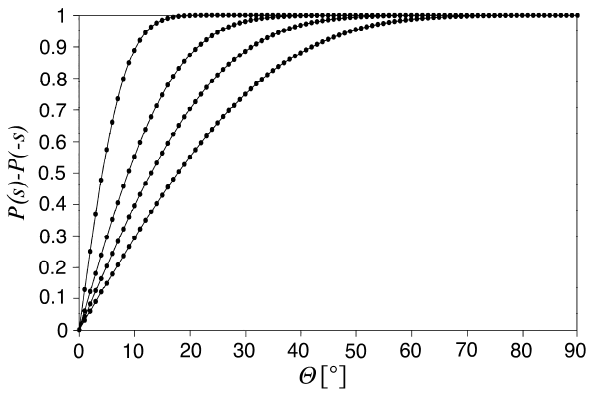
Fig. 3. The cumulative probability P(s) − P ( − s) as a function of the zenith angle θ in air corresponding to s . The curves represent Fig ure 3. The cumulative probability P ( s )- P (- s ) as a function of the zenith angle θ in air from top to bottom the wind speeds 0, 2, 5 and 10ms − 1 . corresponding to s . The curves represent from top to bottom the wind speeds 0, 2, 5 and 10 m s -1 .